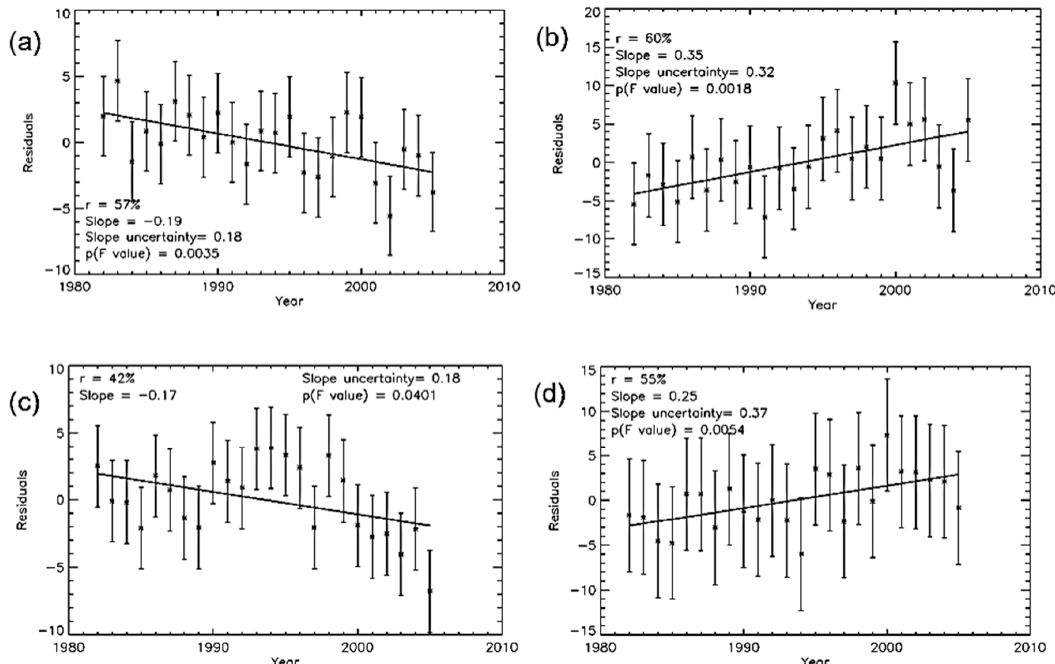
Figure 3. Temporal trends (slopes) of Σ NDVI gs residuals (observed–potential) regressed over time at four locations in the Sahel. The trends in sites ( a , b ) are significantly different from zero ( p value of the F test <0.05 and their absolute values are greater than their respective uncertainty), whereas the trends for the sites shown in ( c , d ) have a p values of the F test <0.05, but the slope values are less than their respective uncertainty.